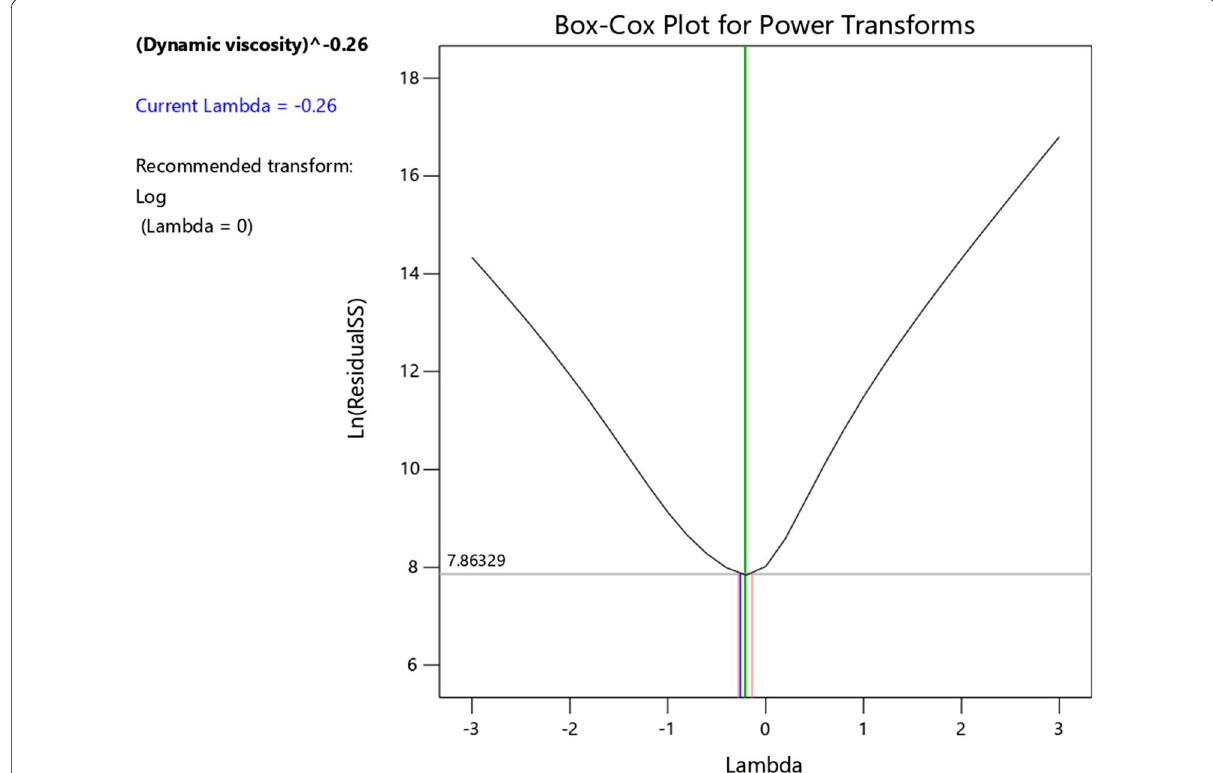
Fig. 14 Box–Cox plot to specify the revised transform function